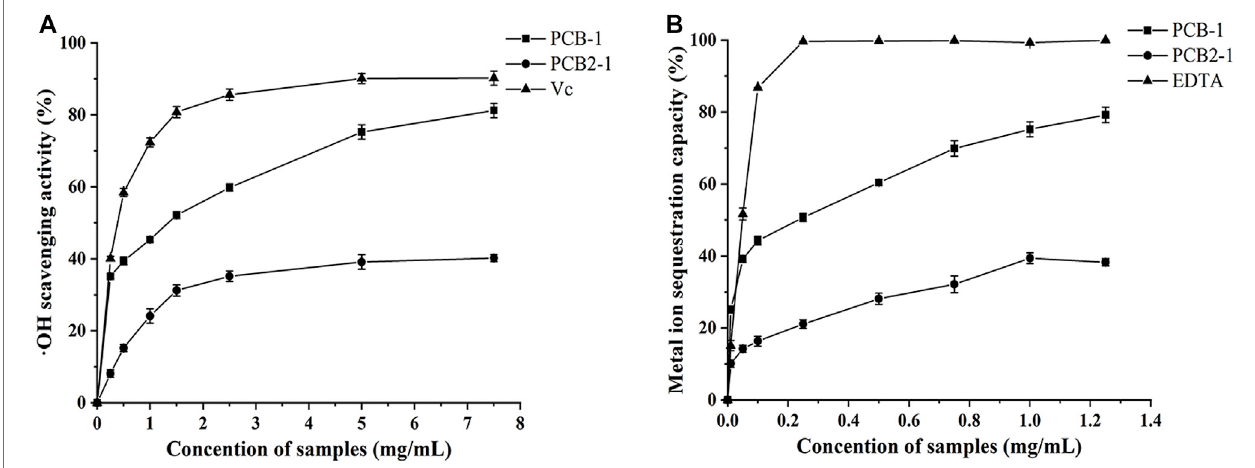
FIGURE5 | Antioxidant activities ofthe polysaccharides from P.cablin : (A) Hydroxylradical scavengingactivity ofPCB-1 and PCB2-1 (B) Fe 2+ chelating activity of PCB-1 and PCB2-1. Each value represents the mean ± SD ( n = 3).